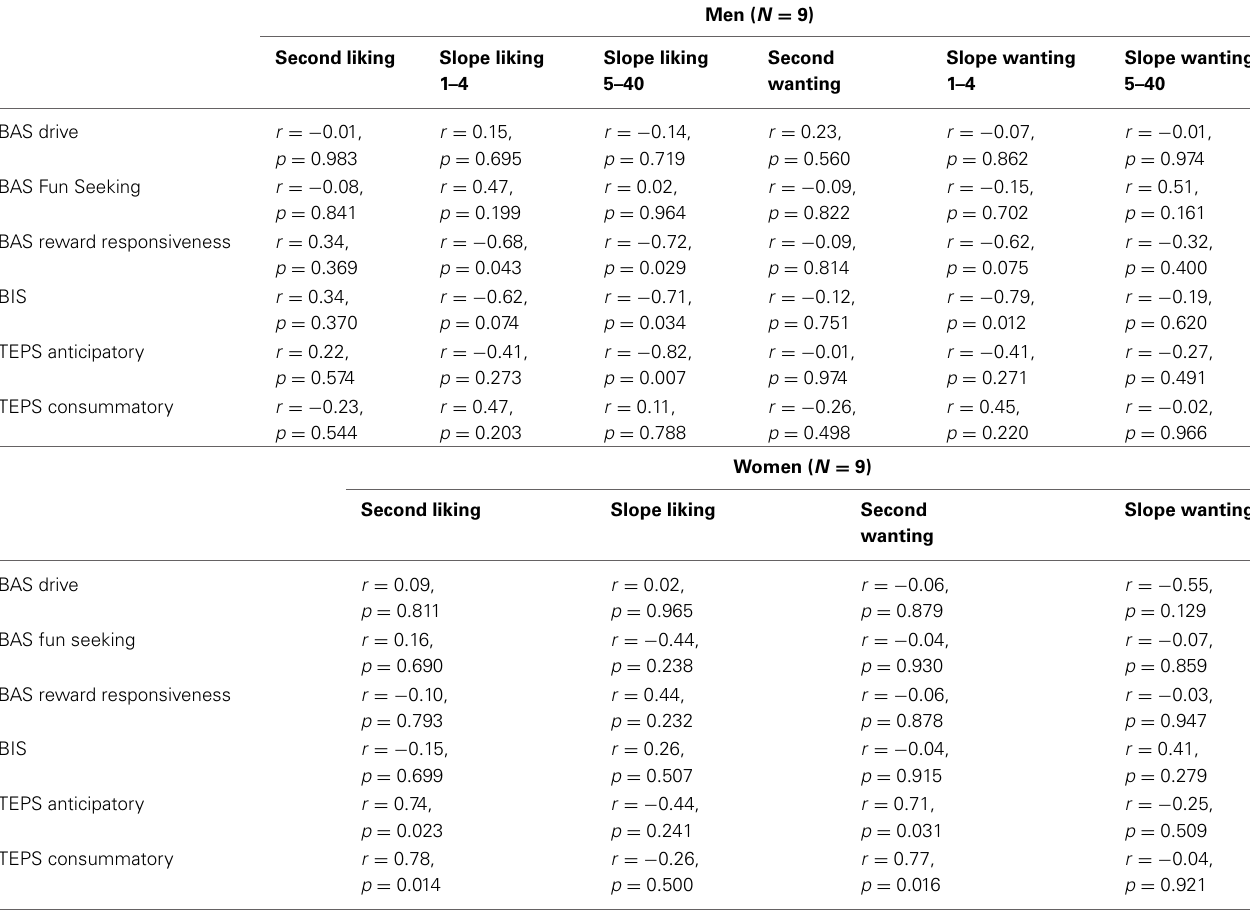
Table 3 | Correlations between ratings and